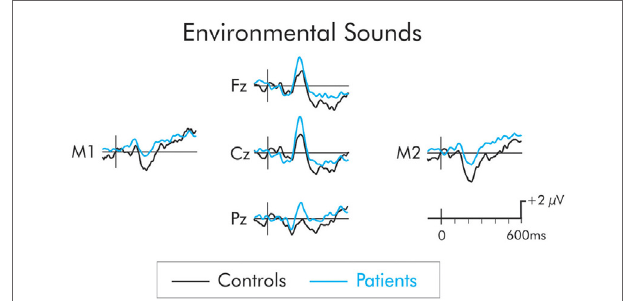
FigUre 5 | P3a following presentation of the environmental sounds for patients (blue) and controls (black). The P3a was significantly larger in patients compared to controls. The prestimulus period for the environmental sounds was not stable and varied between the two groups. As a result, a − 50 to 50 ms parastimulus baseline was